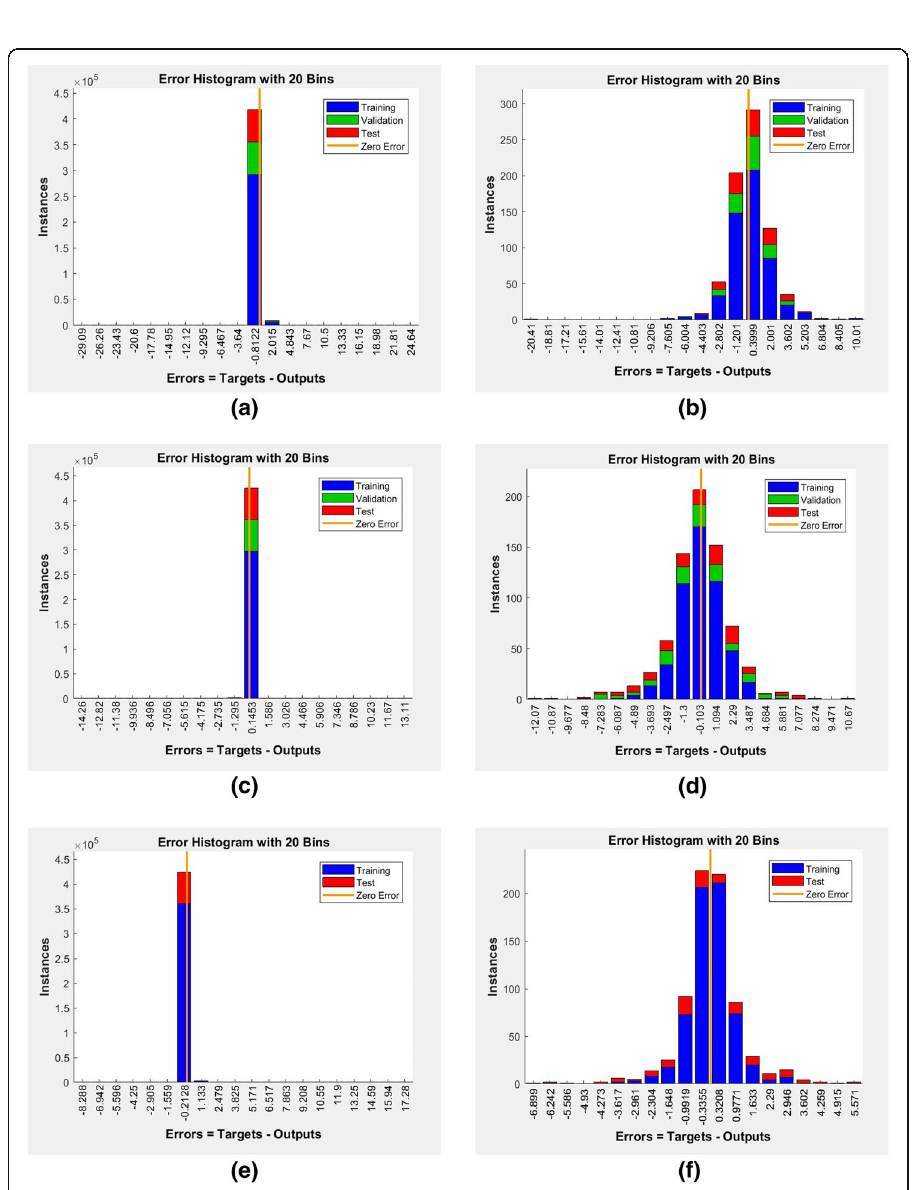
Fig. 5 Error Histogram plots of predictions. ( a ) SCG on tick data: ( b ) SCG on 15-min data: ( c ) Levenberg- Marquardt on tick data: ( d ) Levenberg-Marquardt on 15-min data: ( e ) Bayesian Regularization on tick data: ( f ) Bayesian Regularization on 15-min